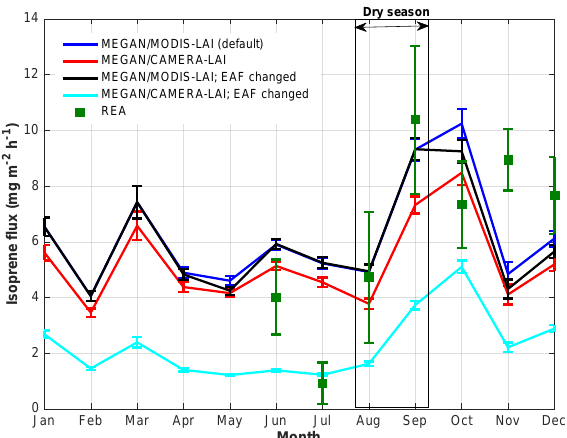
Figure 5. Isoprene flux observed (REA) and estimated with MEGAN 2.1 default mode, leaf age algorithm driven by MODIS- LAI, and with MEGAN 2.1 leaf age algorithm driven by CAMERA- LAI. EAF stands for emission activity factor, which was changed for the different leaf age classes based on emissions of E. coriacea (Alves et al., 2014).